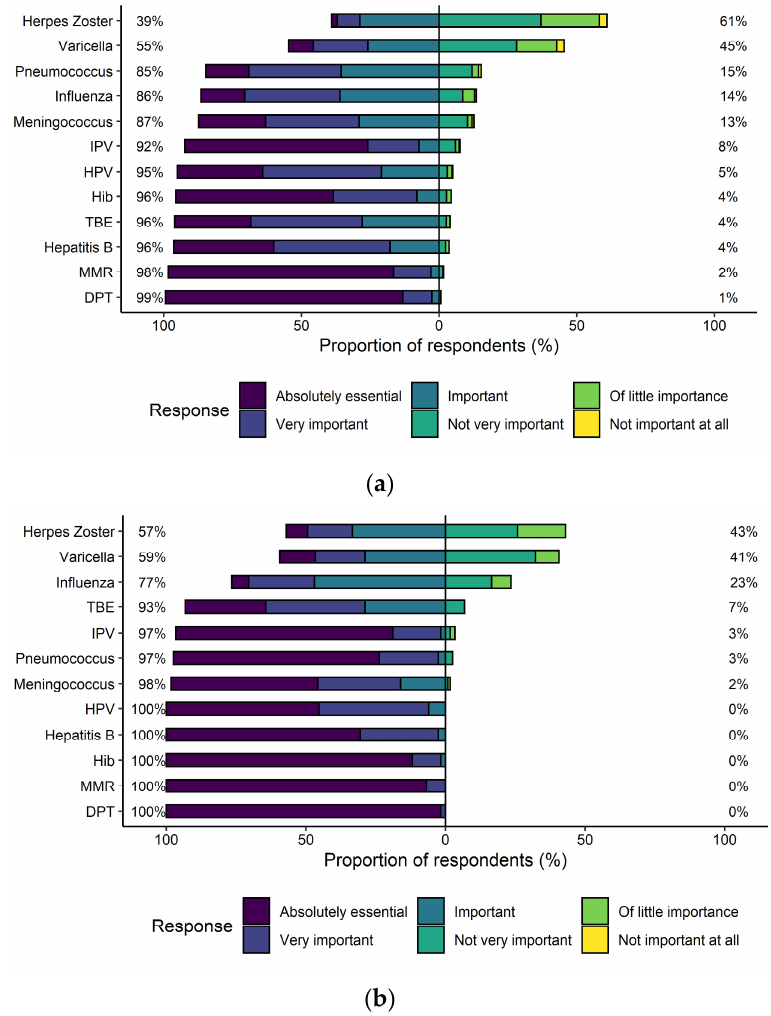
Figure 2. The relevance attributed to recommendations of the Swiss vaccination schedule [10] with the responses stratified into general practitioners ( a ) and pediatricians ( b ). Abbreviations: diphtheria, pertussis, tetanus (DPT); Haemophilus influenzae type b (Hib); human papillomavirus (HPV); inactivated polio vaccine (IPV); measles, mumps, rubella (MMR); tick-borne encephalitis (TBE).